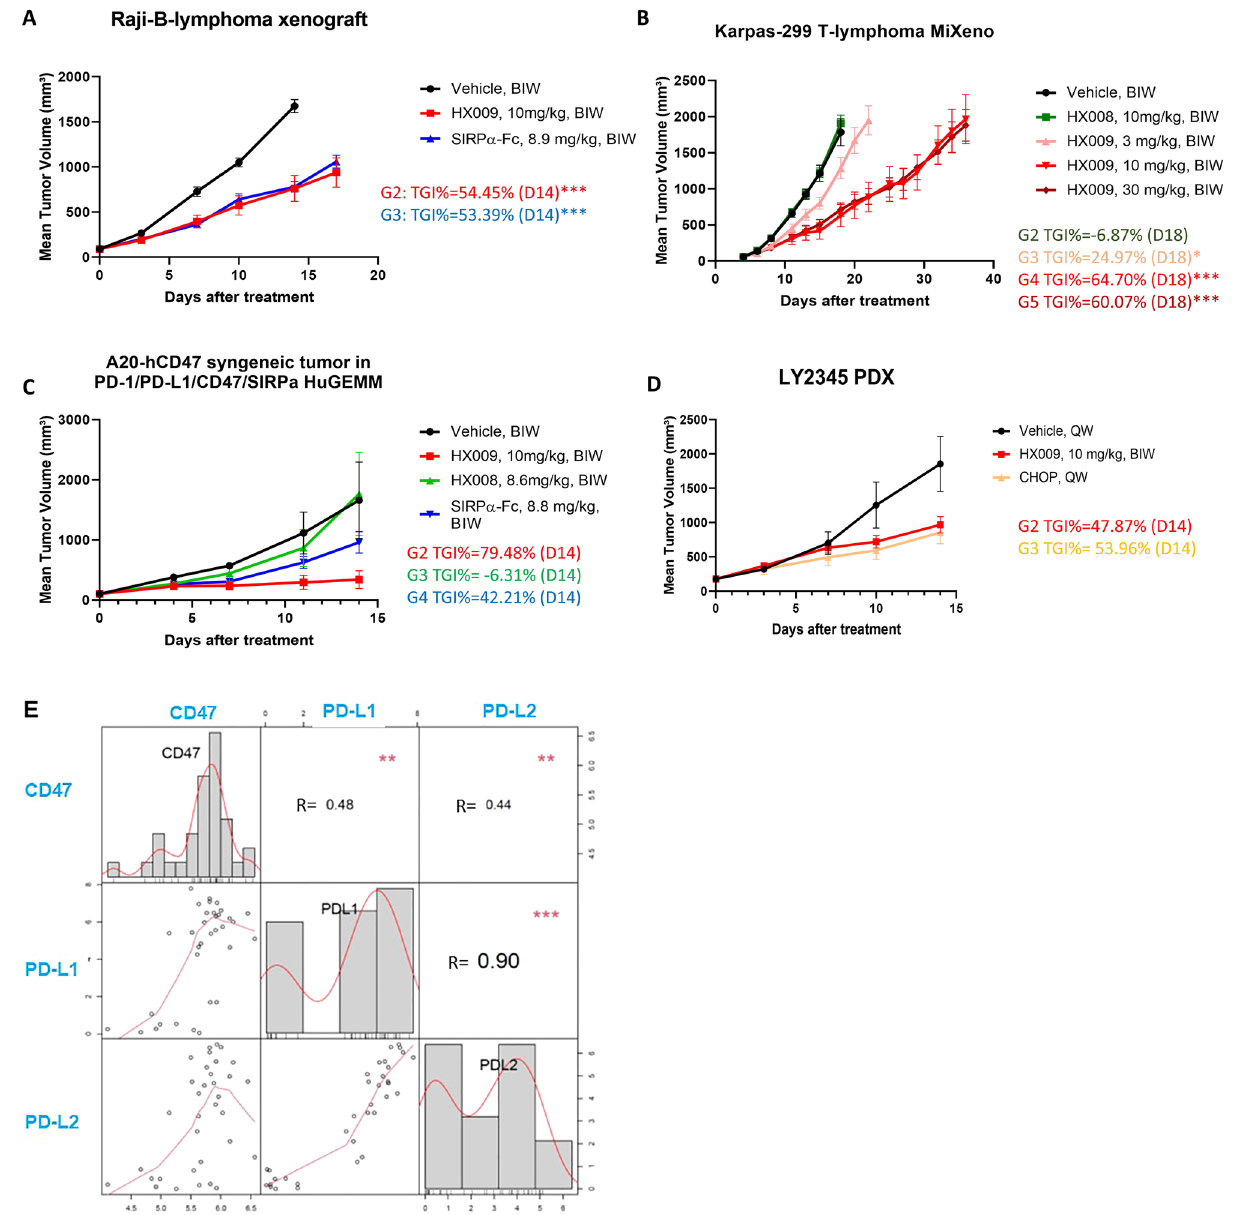
Figure 3. In vivo anti-lymphoma activities HX009 in three different types of preclinical lymphoma models (Table 1) as presented by the tumor growth inhibition curves ( A – D ), and the expression correlations among the immune checkpoints, CD47 , CD274 (encoding PD-L1) and PD-L2 genes in DLBCL ( E ). Tumor growth was measured twice a week and is shown as average tumor size per group ± SEM. Statistical significance was determined by one-way ANOVA. Gene expression correlations at mRNA levels measured by RNAseq (log2(TPM). TPM represents "Transcripts Per Kilobase Million" and the correlation at protein levels measured by IHC-H-scores. ( A ) Human Raji-B-lymphoma xenograft model (The treatment TGI values were displayed next to the curve; G2: HX009 group and G3: SIRPα-Fc group); ( B ) Human Karpas-299 T-lymphoma xenograft (“MiXeno”) model (G2: HX008 group, G3: HX009-3 mg/kg group, G4: HX009-10 mg/kg group, G5: HX009-30 mg/kg group); ( C ) Humanized mouse syngeneic A20-B lymphoma model (HuGEMM PD-L1 × PD1 × CD47 × SIRPα) (G2: HX009 group and G3: HX008 group, and G4: SIRPα-Fc group); ( D ) A representative lymphoma PDX (G2: HX009 group and G3: CHOP group); ( E ) Correlation of the CD47, PD-L1 and PD-L2 mRNAs levels among the DLBCL-PDXs, the corresponding R-values/p-values are displayed in the figure, p -values: ***:0–0.001, **: 0.001–0.01, *: